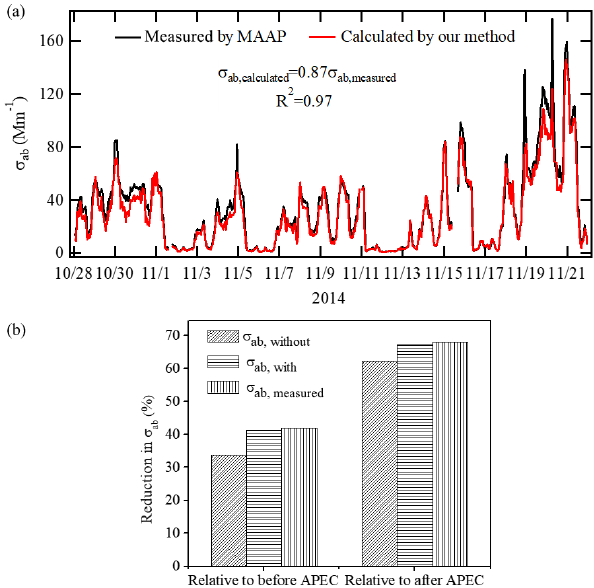
Figure 7. (a) The light-absorption coefficient ( σ ab ) at 670nm. (b) Reduction in the absorption coefficients ( σ ab ) of BC-containing particles observed in the pollution episode during APEC relative to those before and after APEC. The correlation between the cal- culated σ ab ( σ ab , calculated ) using Mie theory combined with SP2 measurements and the measured σ ab ( σ ab , measured ) by MAAP is also shown in (a) . The σ ab , with and σ ab , without values represent σ ab , calculated values with and without, respectively, considering the differences in the light-absorption capability of ambient BC- containing particles among the episodes before, during and after